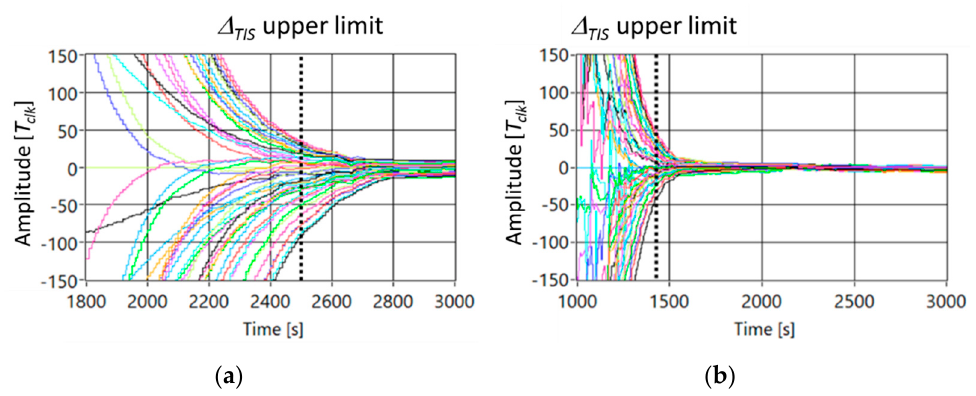
Figure 5. Trend of the delay among nodes in the case Nc = 49 and ( a ) static topology, and ( b ) MSO is randomly moving.